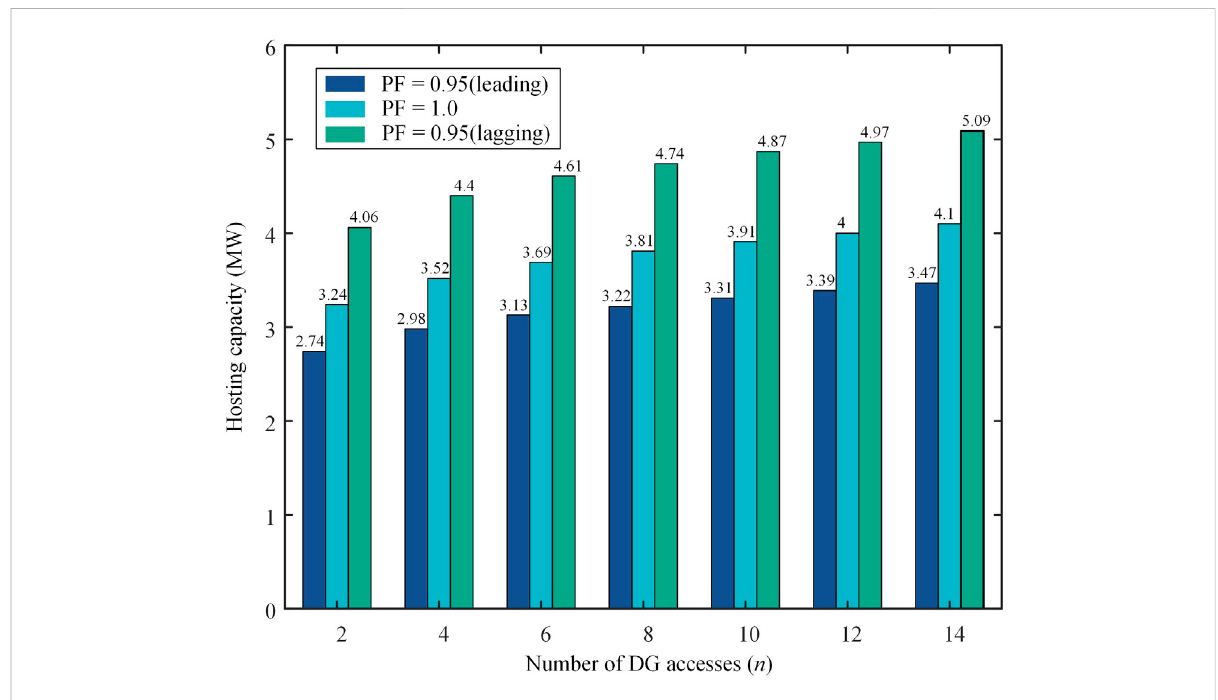
FIGURE 9 DG hosting capacity at different power factors and access